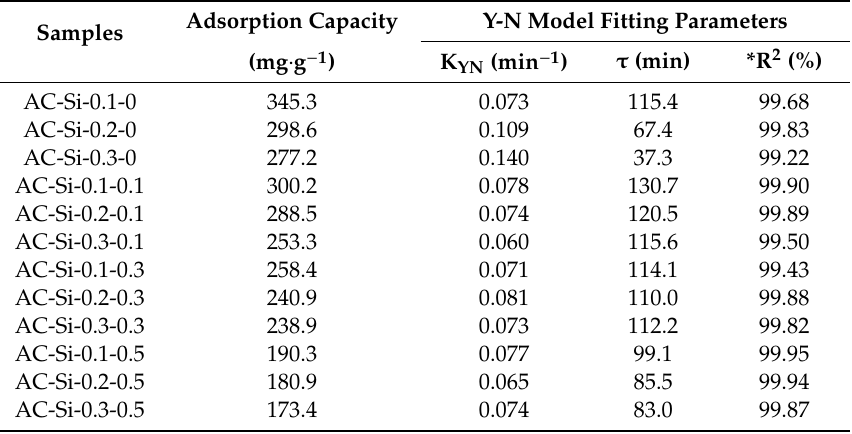
Table 1. Adsorption capacity for various samples and corresponding kinetic parameters.